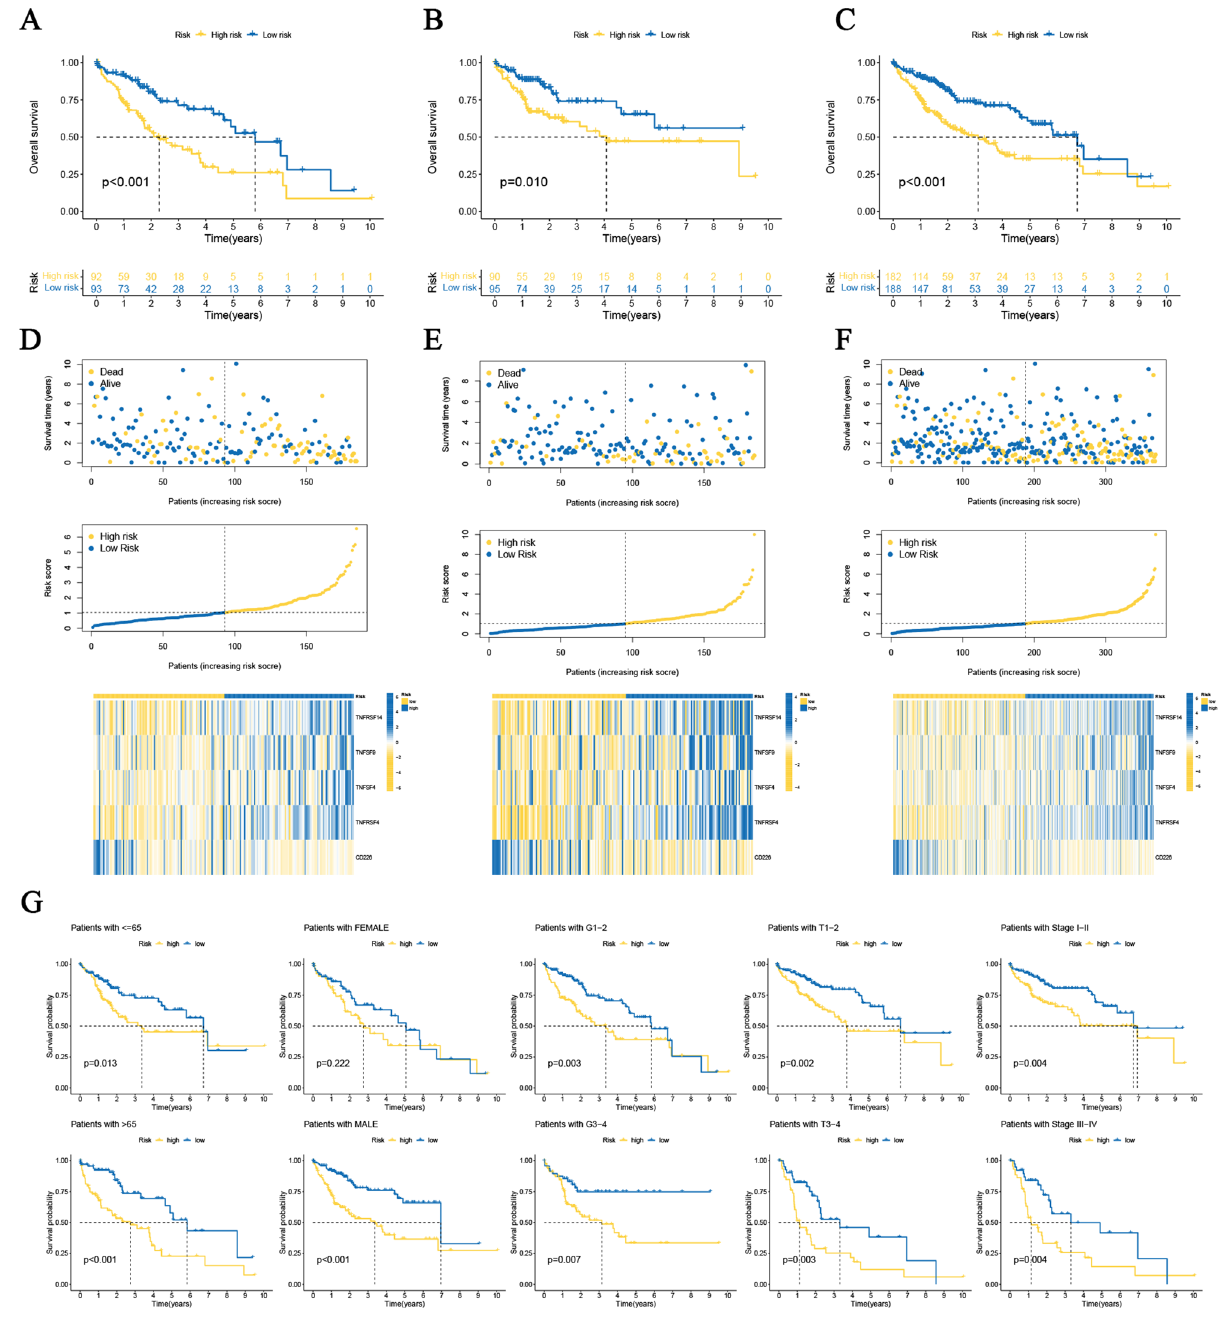
Figure 3. Prognosis value evaluation of cuproptosis ‐ related ICGs model. ( A–C ) The overall survival value of the training, testing, and overall cohorts. ( D – F ) The distributions of survival status, risk scores, and expression heatmap in the training, testing, and overall cohorts. ( G ) Overall survival value stratified by clinicopathologic